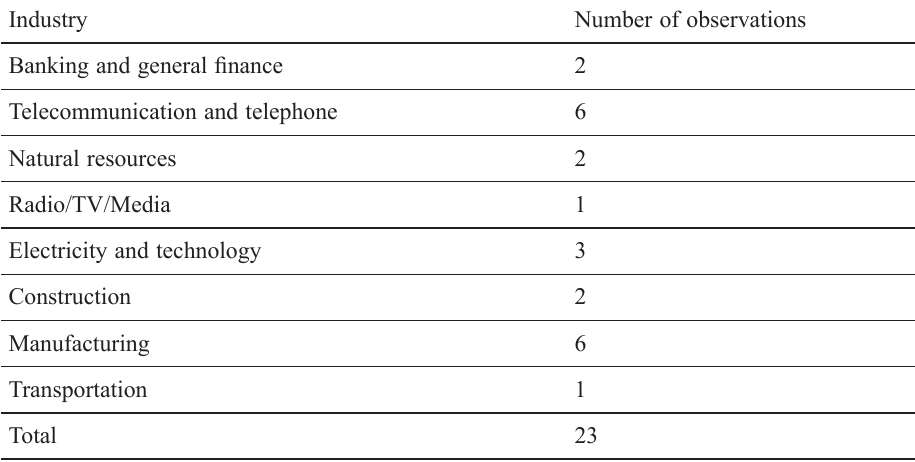
Table 5. Industry distribution of